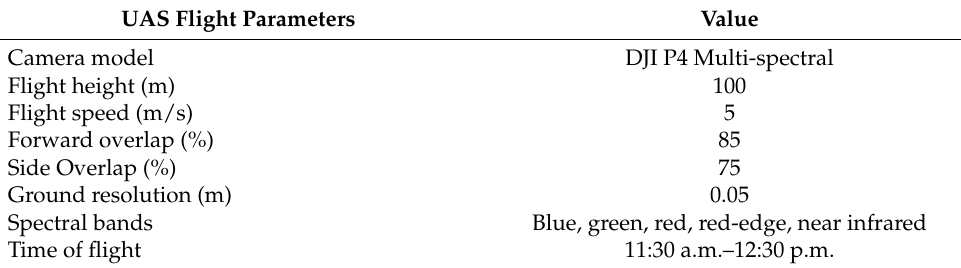
Table 2. Imagery acquisition